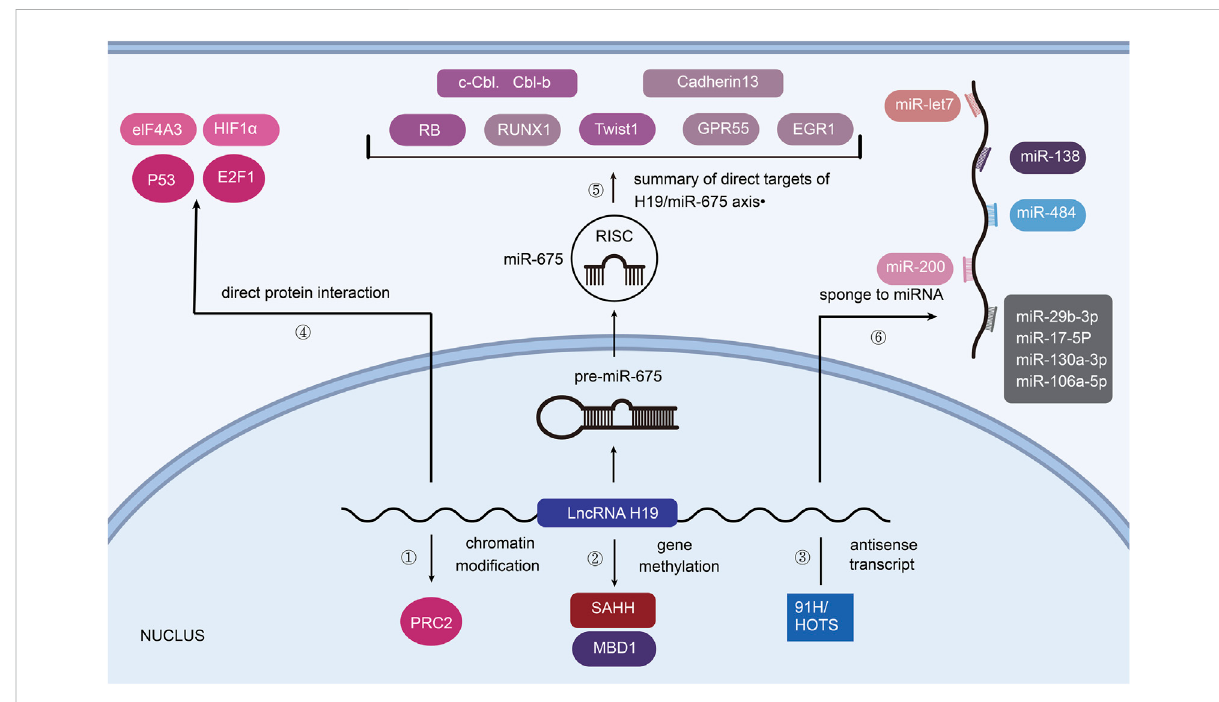
FIGURE 1 H19 associated mechanisms towards tumorigenesis. ① PRC2 consists of core components (EZH2/EZH1, EED, SUZ12). ② H19 binds SAHH or MBD1 to promote the methylation of imprinted genes. ③ 91H and HOTS are the antisense transcripts of H19. ④ p53, E2F1 and eIF4A3, HIF1 α can directly interact with H19 to affect tumorigenesis. ⑤ H19 is the precursor of miR-675. ⑥ H19 acts on post-transcriptional control as